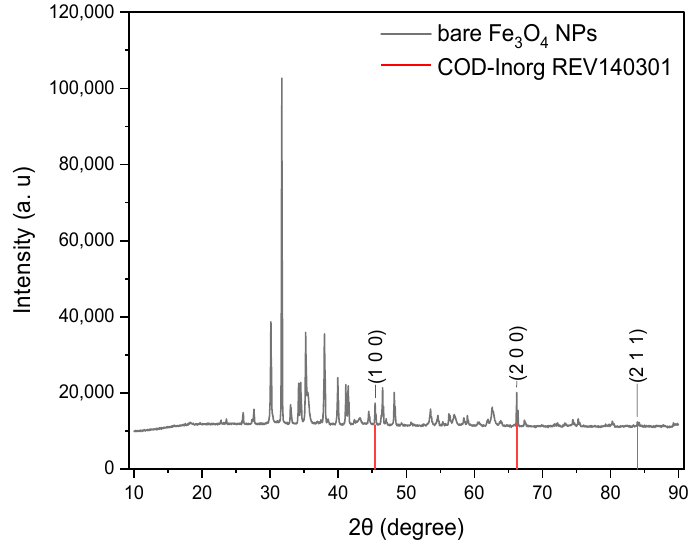
Figure 6. XRD patterns of bare Fe 3 O 4 NPs.